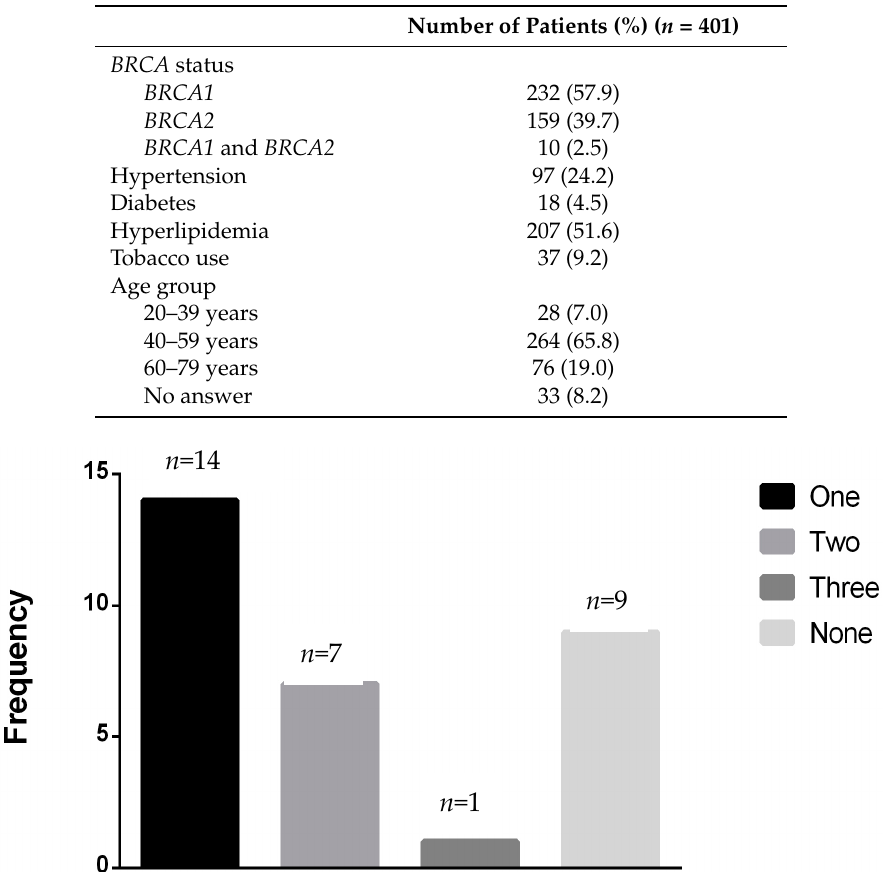
Table 1. Patient characteristics.